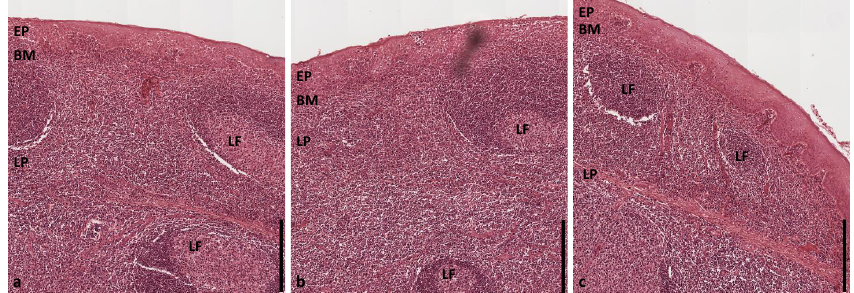
Figure A10. Supplementary HE stained histological cross sections of the mucosal tissue of the human tonsil [44]. EP: epithelium, BM: basement membrane, LP: lamina propria, LF: lymphoid follicle. Scale bar: 200 µ